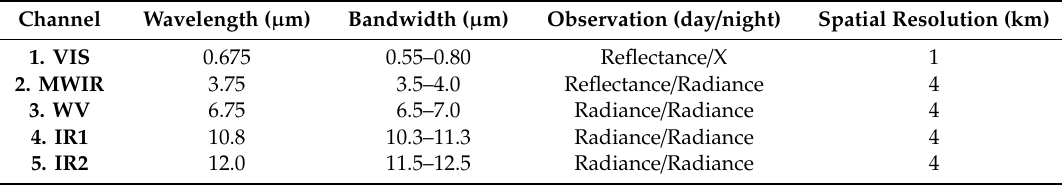
Table 1. Spectral channel characteristics of the meteoritical imager (MI) on